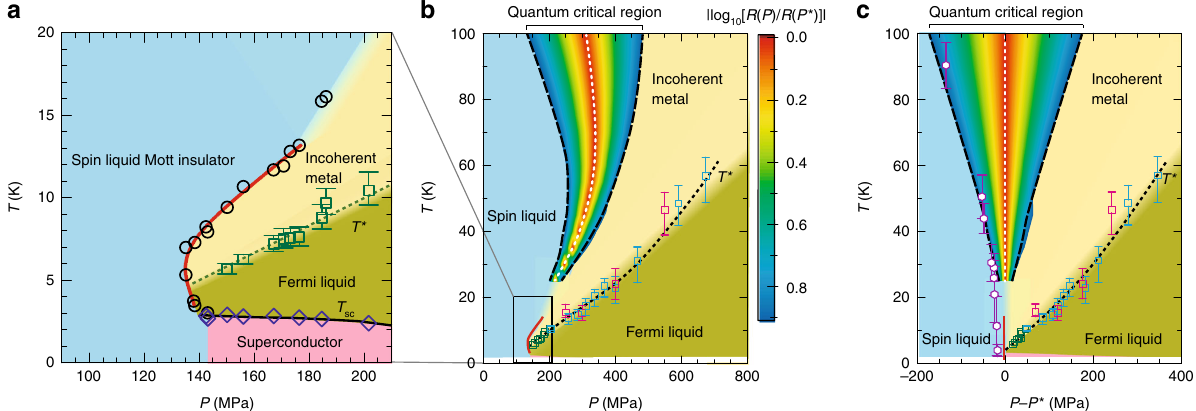
Fig. 1 Pressure – temperature phase diagram of κ -(ET) 2 Cu 2 (CN) 3 . a Low-temperature phase diagram in the vicinity of the Mott transition constructed from the resistance behaviours of samples #1 and #2. The black open circles indicate the points at which resistive jumps associated with the fi rst-order Mott transition were observed, and the red bold line is a fi t to the data points and was used in the entropy analyses (Fig. 4a – d). The blue diamonds indicate the onset of the superconducting transition T sc . The green squares indicate the coherence temperatures T * . We de fi ned T * as the temperature at which the deviation in resistance R ( T ) from the T 2 law characteristic of the Fermi liquids, R fi t ( T ) = R 0 + AT 2 , exceeded 10% of AT 2 , which fi ts the low-temperature data (see Fig. 2b and Supplementary Fig. 4). We evaluated the upper and lower bounds of errors in T * as the temperatures yielding 15 and 5% deviations of R ( T ), respectively. b Phase diagram over a wide temperature – pressure range. The squares indicate the T * values determined from the resistance behaviours of samples #1 (green), #3 (pink) and #4 (blue). The white broken line indicates the Mott crossover pressure (the Widom line), P * ( T ), taken from ref. 15 . The fan-shaped contour plot, which is reproduced from ref. 15 , represents the magnitude of | log 10 R ( P )/ R ( P * ) | in the quantum critical region. c Phase diagram in the P − P * – T plane. The open hexagons indicate the charge gaps (see Fig. 3) divided by a factor of three, Δ /3, in order to see the correspondence with